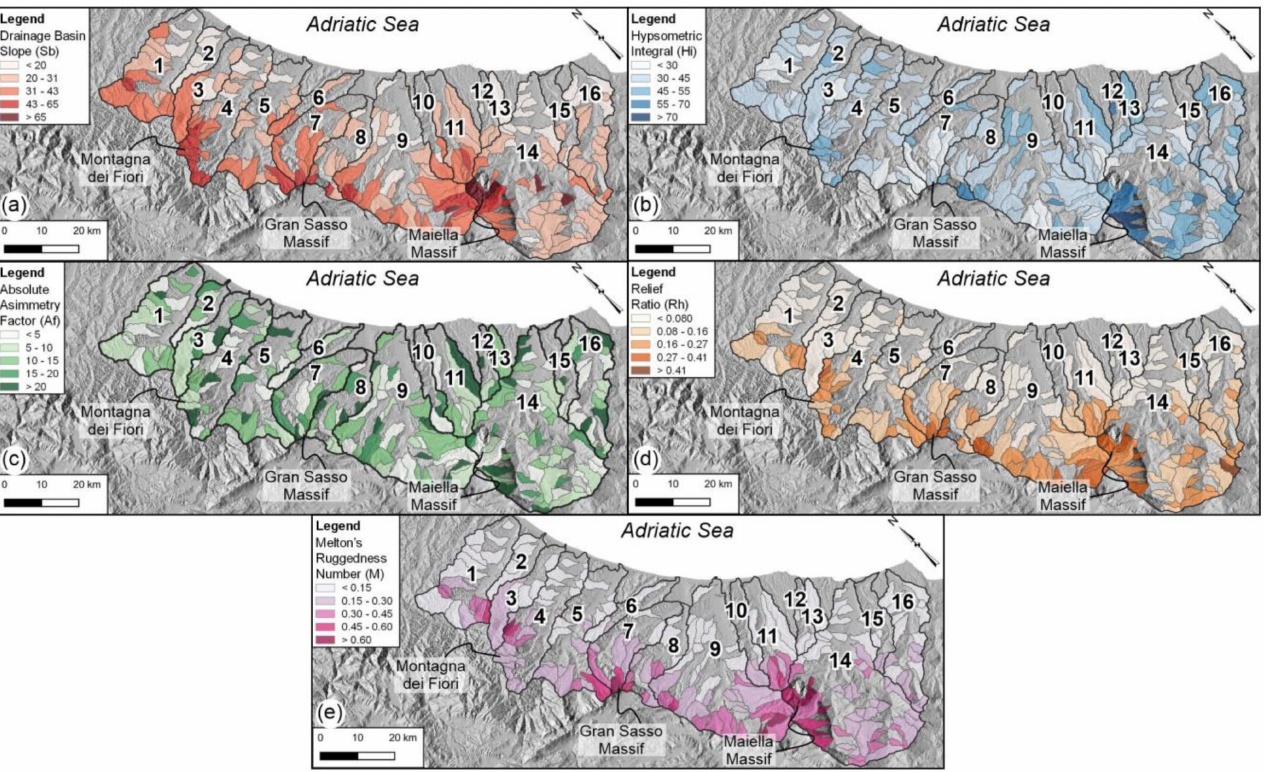
Figure 3. Thematic maps of the main morphometric parameters. ( a ) drainage basin slope (Sb); ( b ) hypsometric integral (Hi); ( c ) absolute asymmetry factor (Af); ( d ) relief ratio (Rh); ( e ) Melton’s ruggedness number. Black lines represent the watershed of the main 16 basins analyzed. Numbers refer to the basins in Table